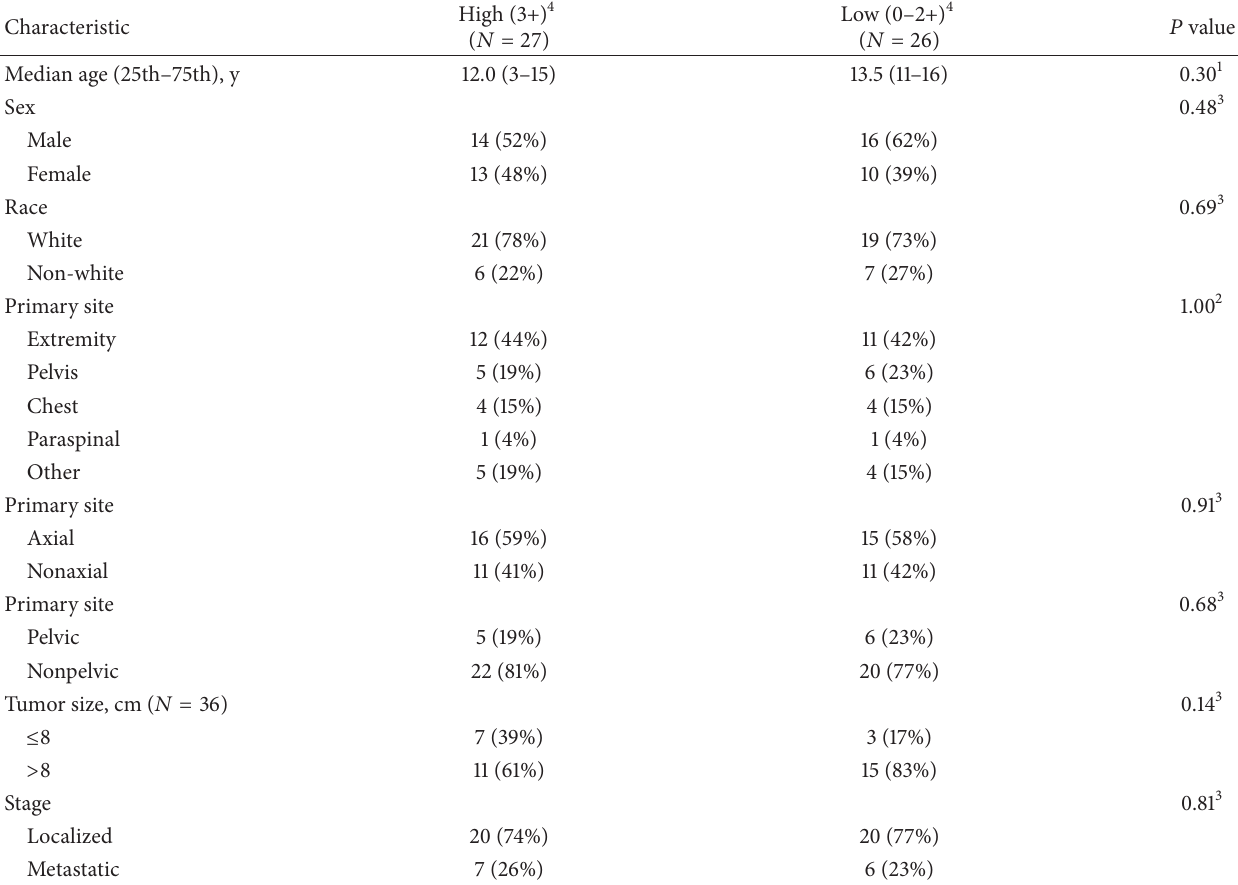
Table 3: Comparison of clinical characteristics between patients with high and low ezrin